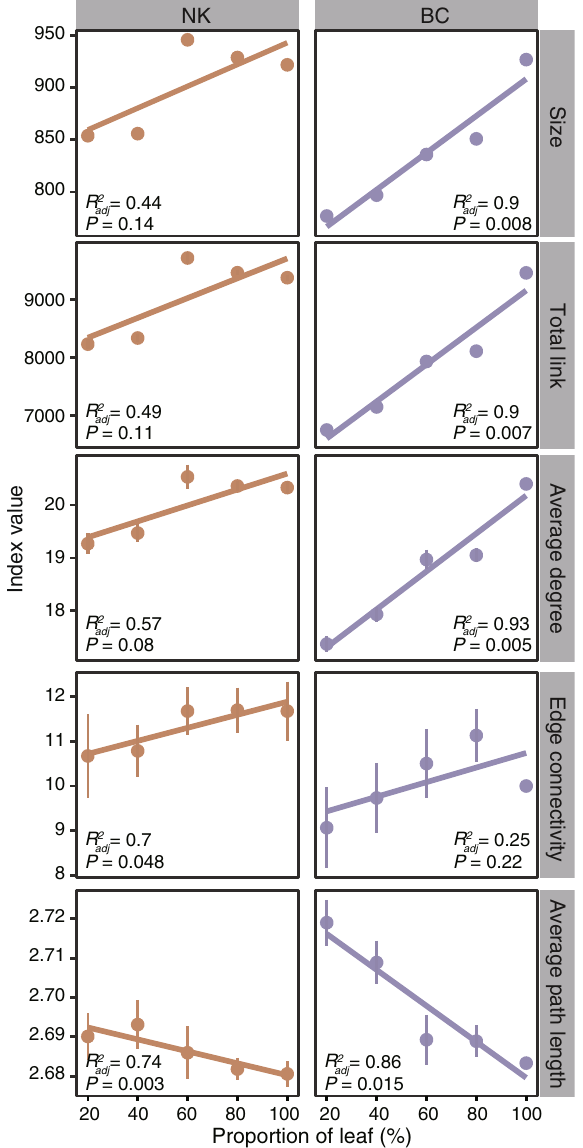
Fig. 3 The relationship between the fi ve properties (Size, Total link, Average degree, Edge connectivity, and Average path length) of gut microbiome co-occurrence network and the diet. The points and error bars on the panels represented mean ± standard deviation after subsampling 999 times. Colors denoted different social groups (orange, NK; purple, BC). The adjusted R 2 values for linear regression were presented. The p -values were obtained from linear regression